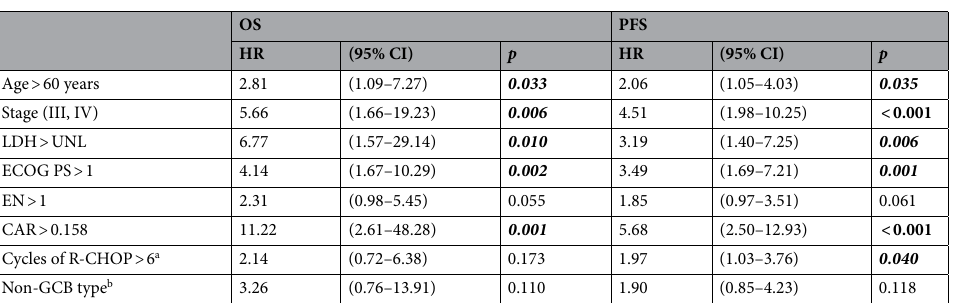
Table 2. Univariable analyses of overall survival and progression-free survival in patients with available pre- treatment C-reactive protein-to-albumin ratio data. OS overall survival, PFS progression-free survival, HR hazard ratio, CI confidence interval, LDH lactate dehydrogenase, UNL upper normal limit, ECOG PS Eastern Cooperative Oncology Group performance status, EN extranodal, CAR C-reactive protein-to-albumin ratio, GCB germinal centre B-cell. a Compared to 6. b Compared to GCB